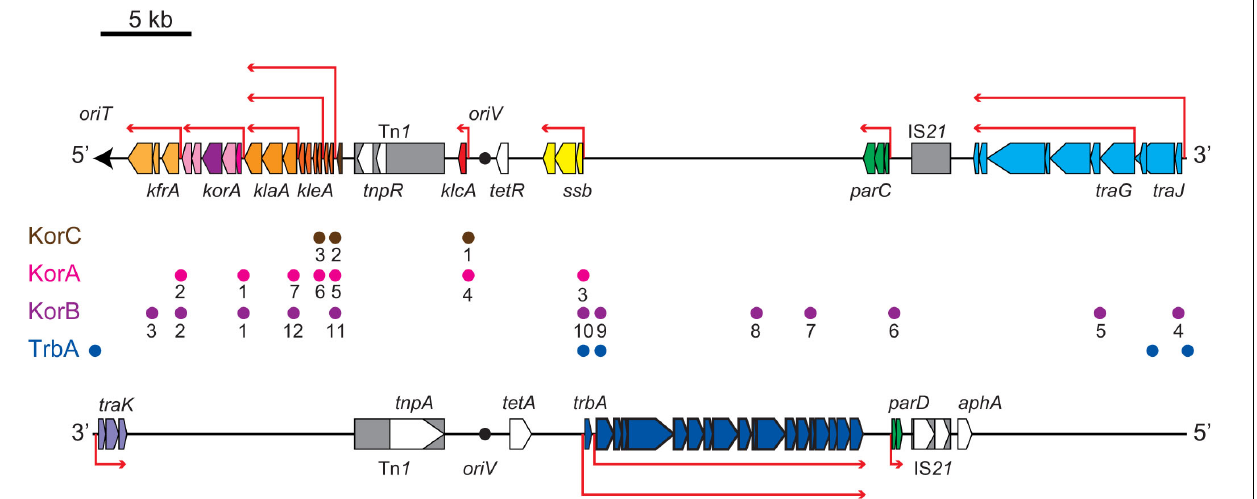
FIGURE 2 | Scheme of RP4 genes encoded on the transfer strand (upper) and the complementary strand (lower). The origin of transfer (oriT) and its direction is indicated by the black arrow. The origin of replication (oriV) is indicated by the black circle. The location and length of representative RP4 genes are indicated by pentagons in the direction of transcription on their respective template strand (antisense strand). Transposon and insertion sequence are shown in gray boxes. Red arrows indicate representative polycistronic transcription units. Circles between the transfer and complementary strands indicate the operator sequences of the global regulators, KorA (magenta), KorB (purple), KorC (orange), and TrbA (blue). The KorA, KorB and KorC operators (O A , O B , and O C ) are numbered as in Pansegrau et al. (1994a).